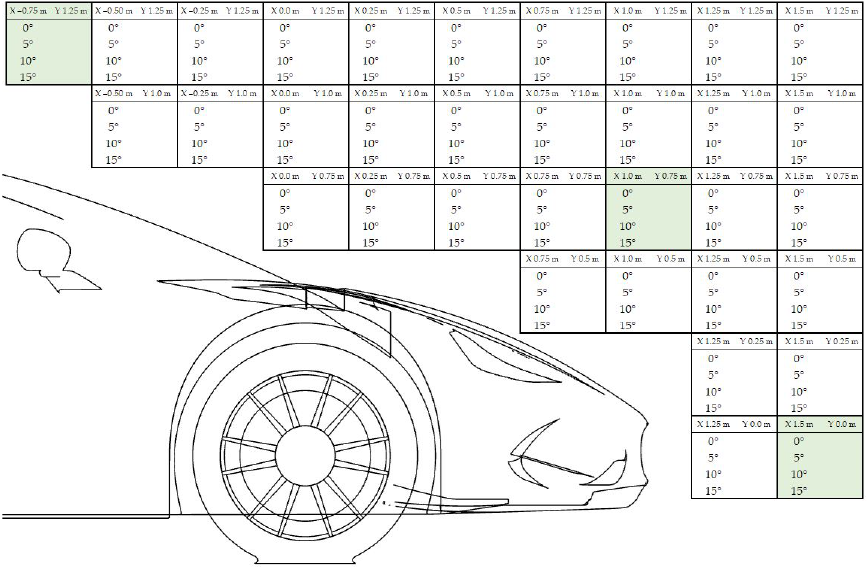
Figure 29. Positions of wings, as visualized in the next